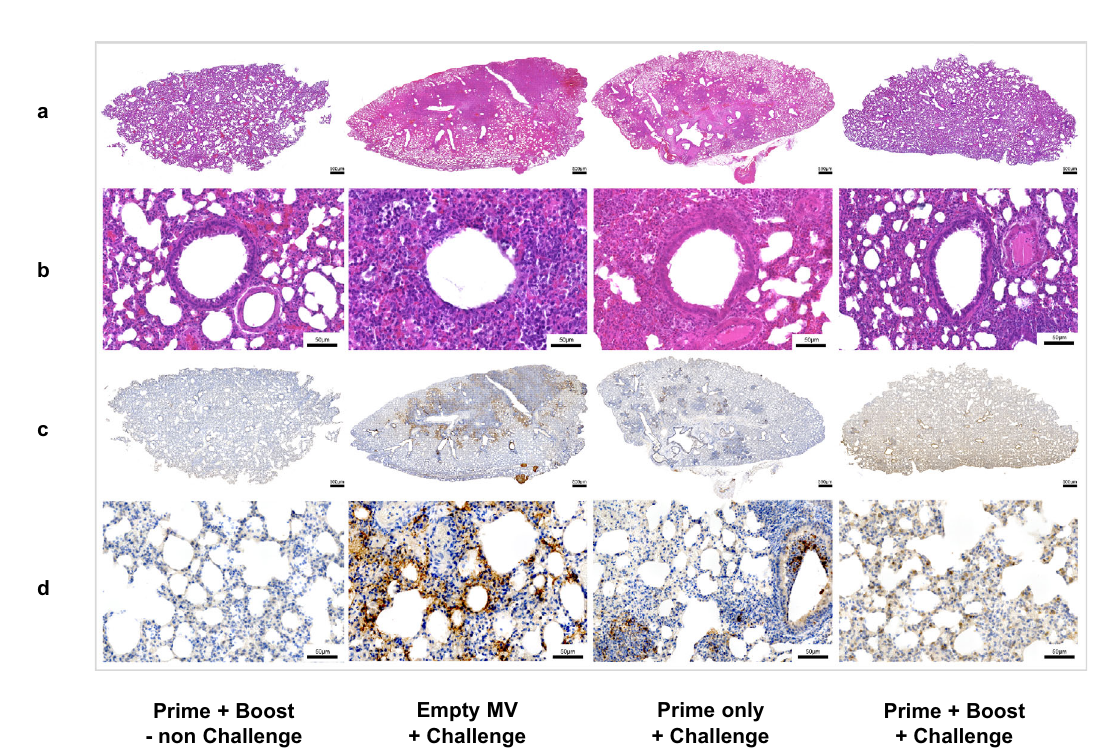
Fig. 9 MV-ATU2-SF-2P-dER immunization protects SARS-CoV-2-challenged golden Syrian hamsters from lung pathology. Histology and Immunohistochemistry of freshly collected lungs at 4 dpi from immunized and challenged hamsters (representative images of n = 8/group). Scale bars are embedded in the lower right corner of each image. a Hematoxylin and Eosin (H&E) stained whole-lung sections. b Bronchiolar epithelium sections. c Whole-lung sections immuno-stained with SARS-CoV-2 N antibody. d High magni fi cation of the immuno-stained lung